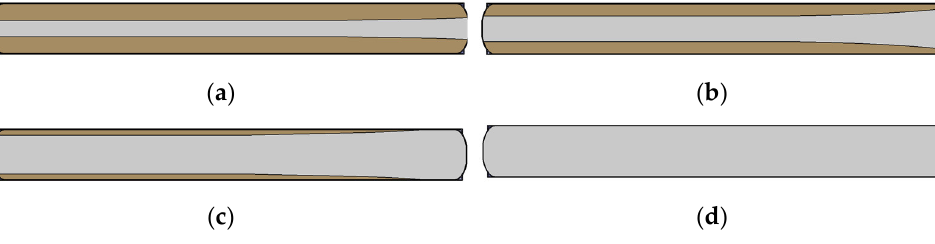
Figure 8. Changes of engine internal structure during grain combustion, ( a ) 2 s, ( b ) 6 s, ( c ) 10 s and ( d ) 13 s.